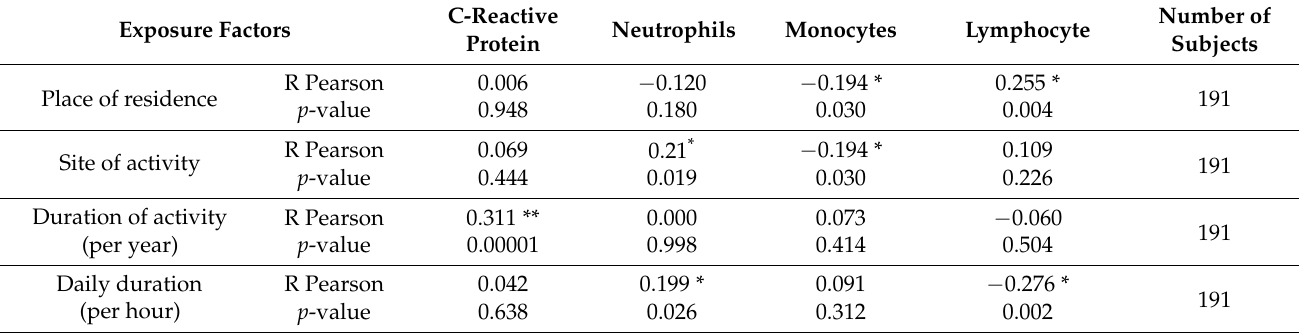
Table 6. Influence of exposure factors on the changes of some blood